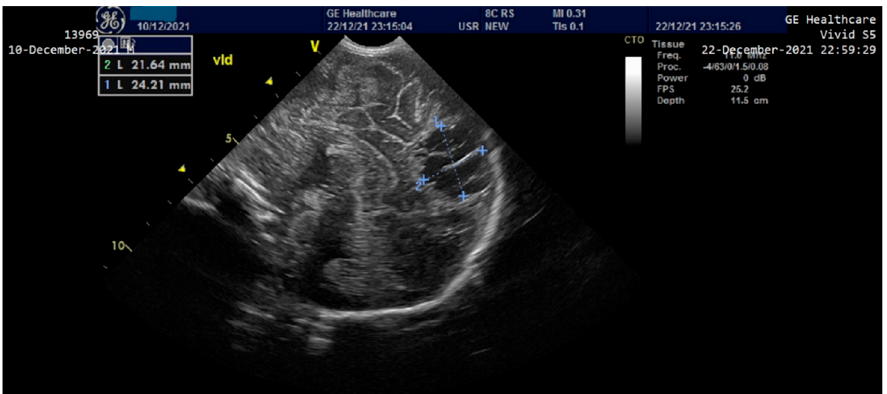
Figure 3. Cranial ultrasound in the first 24 h of life with round-oval hyperechoic image 0.6/0.4 cm in the left frontoparietal cerebral parenchyma.